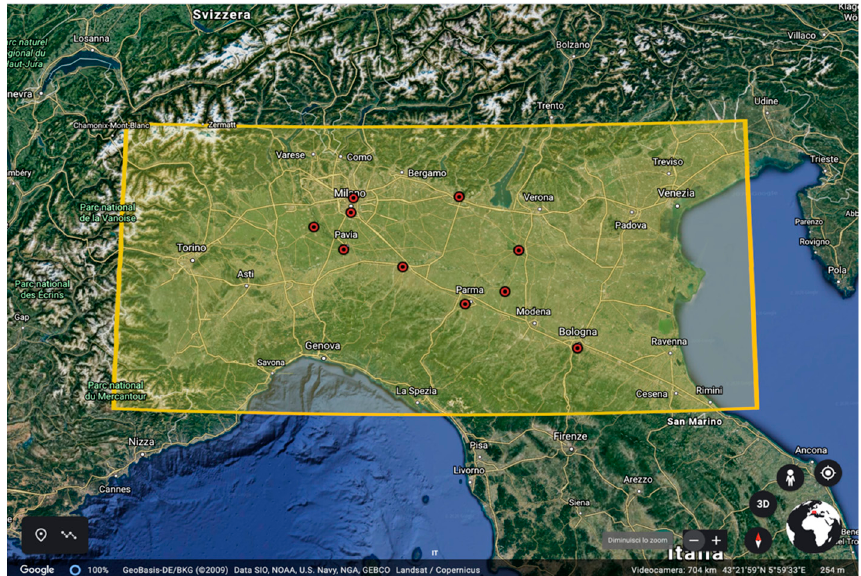
Figure 1. The first target area, (yellow box), located in the North of Italy. This area includes the Po Valley. The red circles indicate the ground stations considered for the validation of the results.